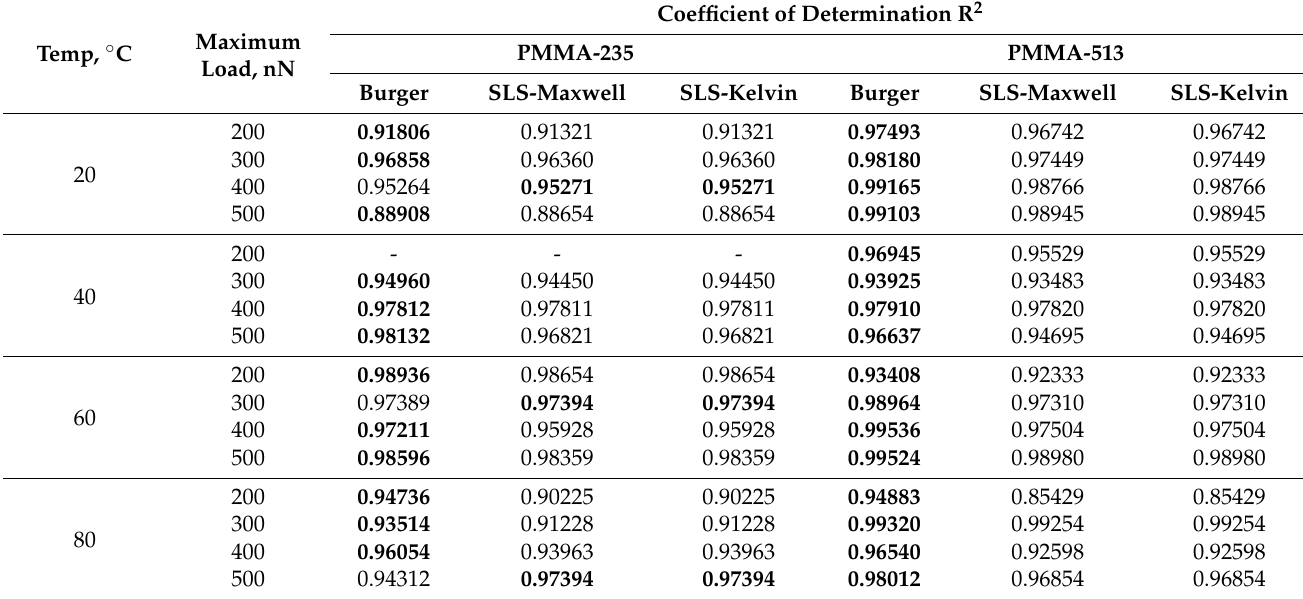
Table 2. Coefficients of determination R 2 for fittings of Burger, SLS-Maxwell and SLS-Kelvin models for experimental creep compliances curves.